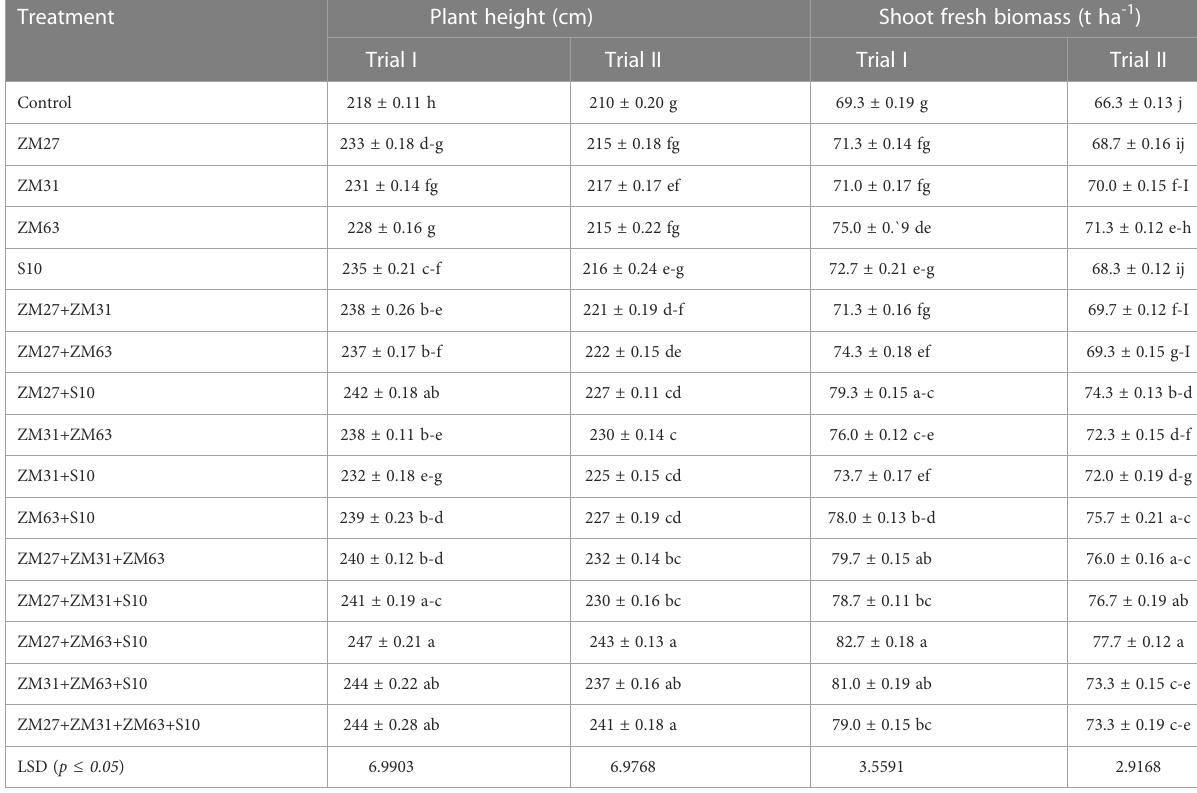
TABLE 3 Effect of novel bio inoculants on plant height and shoot fresh biomass of maize in fi eld trials. Treatment Plant height